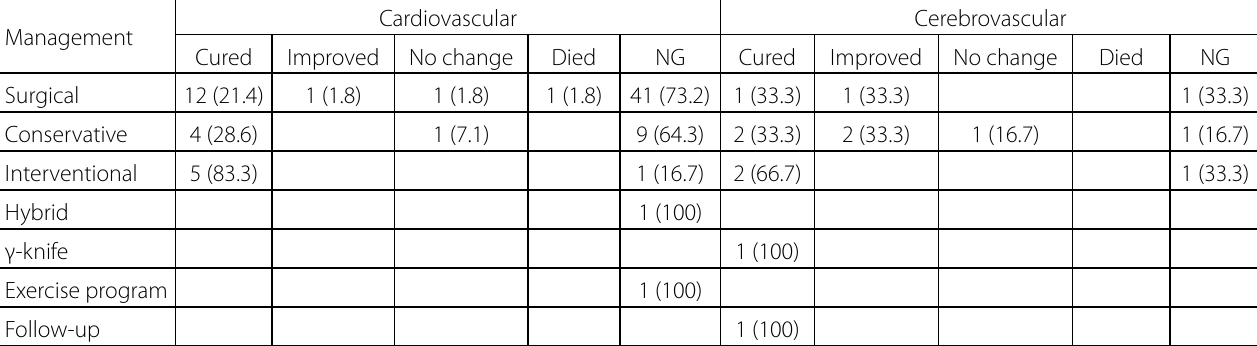
Table 5. Clinical outcomes of cardiovascular and cerebrovascular complications subjected to various management strategies, n (%).